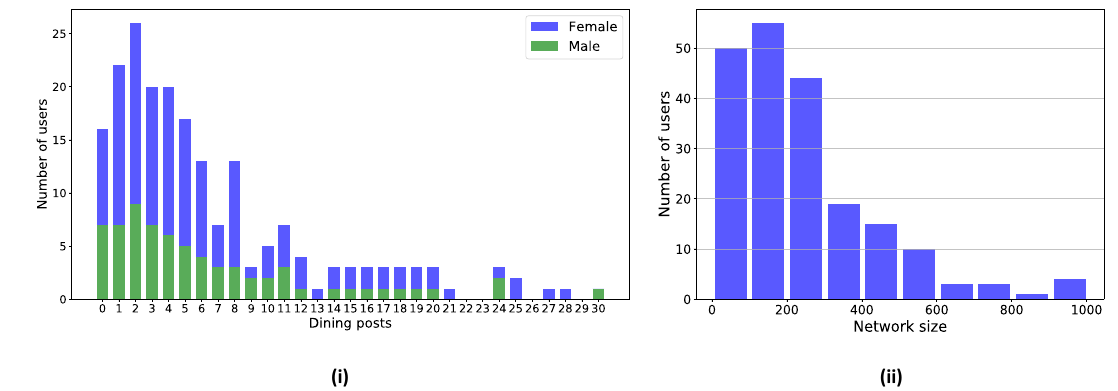
Figure A1. ( i ) Distribution of the dining posts (shown for both males and females) ( ii ) Network (number of profiles followed by a user) size